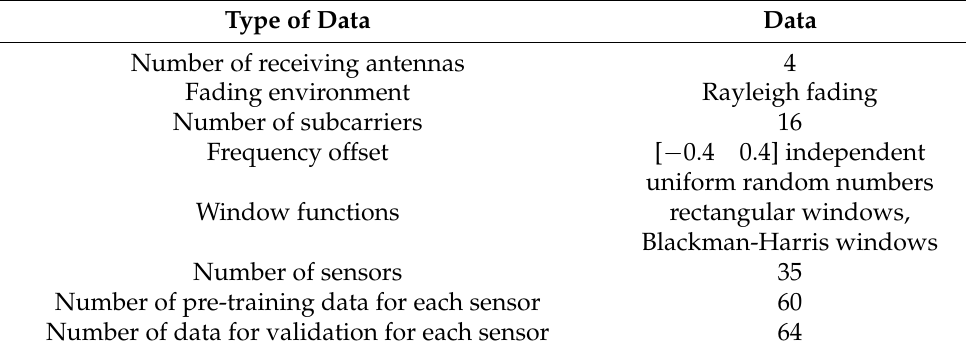
Table 1. Simulation parameters.